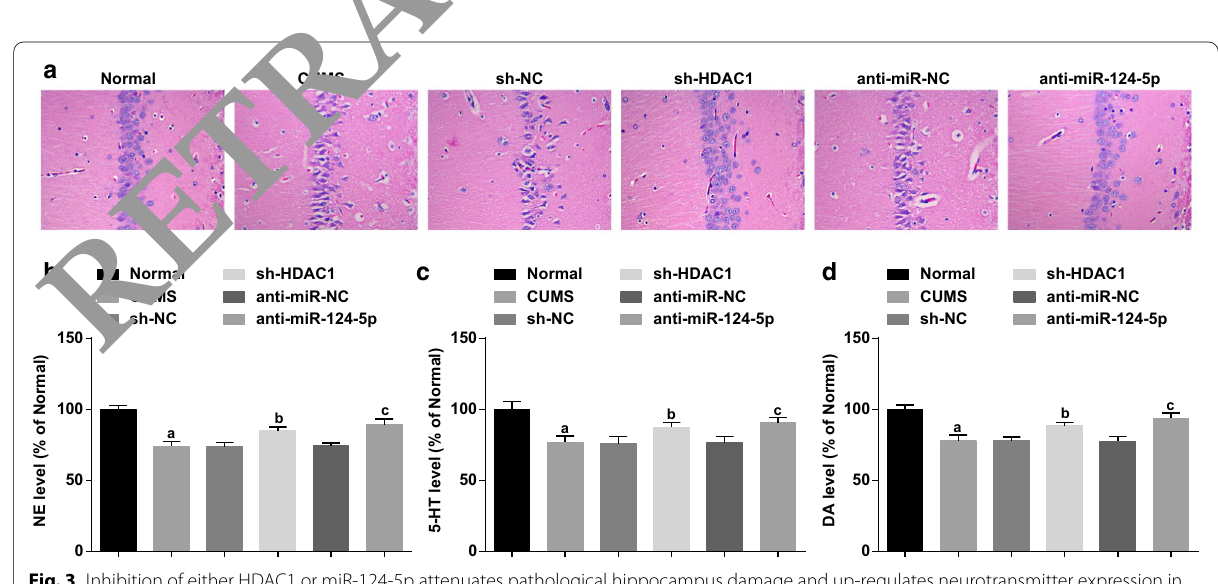
Fig. 3 Inhibition of either HDAC1 or miR-124-5p attenuates pathological hippocampus damage and up-regulates neurotransmitter expression in depressed rats. a HE staining of hippocampal lesions of depressed rats; b ELISA of NE expression in hippocampal tissues; c ELISA of 5-HT expression in hippocampal tissues; d ELISA of DA expression in hippocampal tissues; n 6; a P < 0.05 compared with the normal group; b P < 0.05 compared = with the sh-NC group; c P < 0.05 compared with the anti-miR-NC group. Comparisons among multiple groups were evaluated by one-way ANOVA, and pairwise comparisons by Tukey’s post hoc